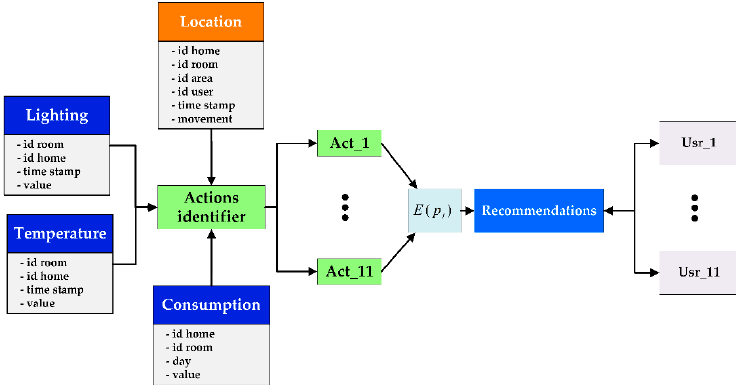
Figure 8. The social machine receives data from the localization engine and the sensor network to identify the actions that are being carried out. With the current and historical data gathered, the social machine calculates the reputation of each action to provide customized recommendations to the users.